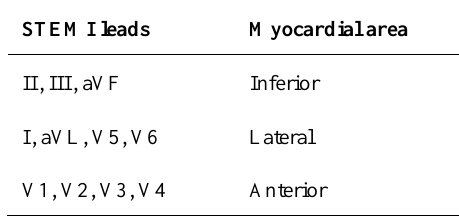
Table 1. ECG leads and portion of heart